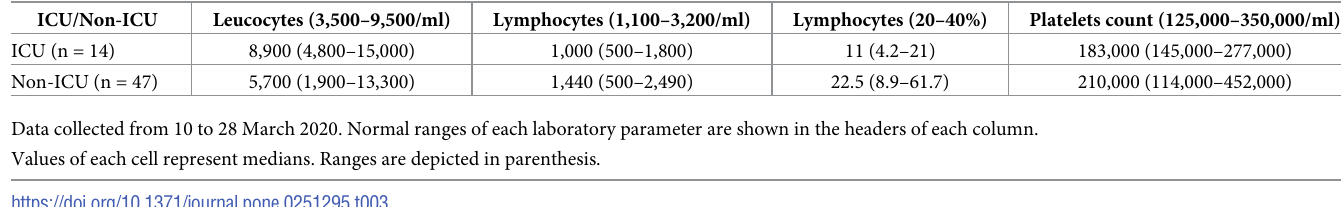
Table 3. Leucocyte, lymphocyte, and platelet counts for laboratory confirmed (n = 61) COVID-19 cases by Intensive Care Unit (ICU) admission status in the Hospi- tal General del Sur de Quito (HGSQ), Quito, Ecuador—March 2020. ICU/Non-ICU